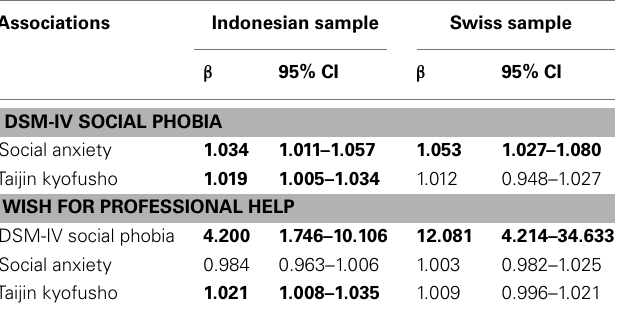
Table 2 | Logistic regression for associations with the dependent variables “self-report DSM-IV social phobia” and “wish for professional help for social anxiety symptoms” in the Indonesian ( N = 311) and Swiss sample ( N = 344).